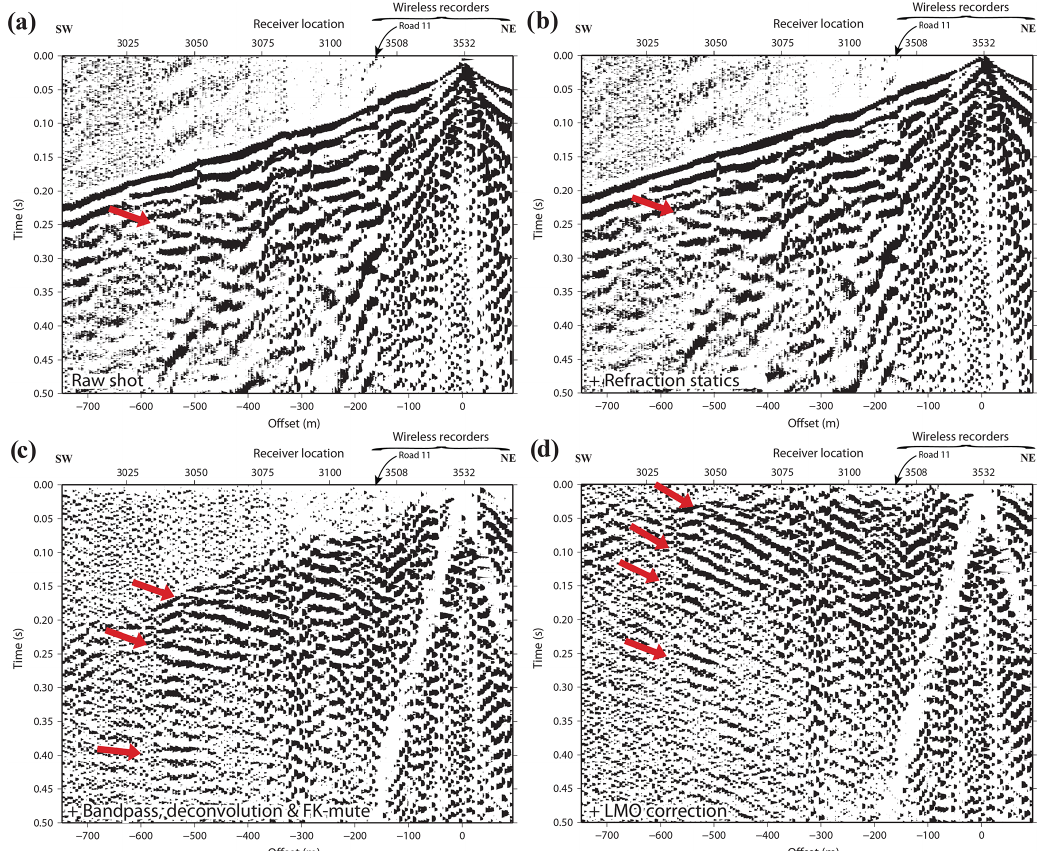
Figure 6. (a) An example shot gather from profile 3 (after vertical stacking of the three repeated shot records) illustrating the quality of the first breaks and the data. Note a clear reflection (dipping towards the northeast) already in the raw data (red arrow) but much stronger after (b) refraction static corrections, (c) prestack data enhancement and (d) LMO corrections (for display purpose). A series of reflections (marked by the red arrows in panels c and d ) is notable between receivers 3025 and